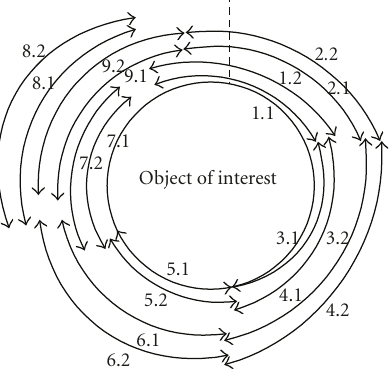
Figure 7: Example of constructed instance set S (cid:9) from S